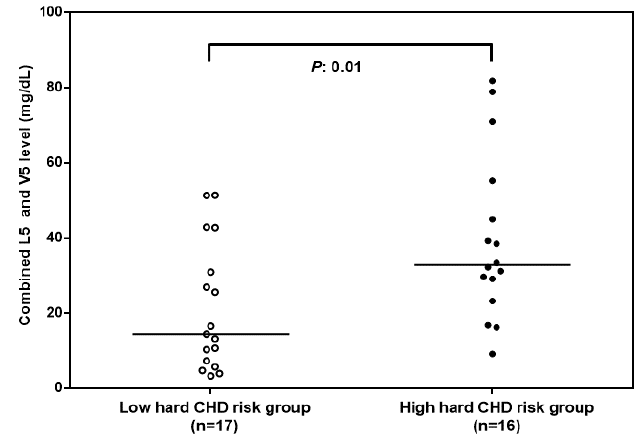
Figure 2. Combined electronegative VLDL and LDL levels in groups of study participants with high or low hard coronary heart disease (CHD) risk. Combined L5 and V5 levels were significantly higher in the high hard CHD risk group (adjusted hard CHD risk ≥ 1.5). The p -value was calculated by using the Mann-Whitney U test. Adjusted hard CHD risk was calculated as the hard CHD risk / average hard CHD risk at the age. The average hard CHD risk at the age was derived from the Framingham heart study [25] of a predominantly Caucasian population. The solid line indicates the median value for each group.